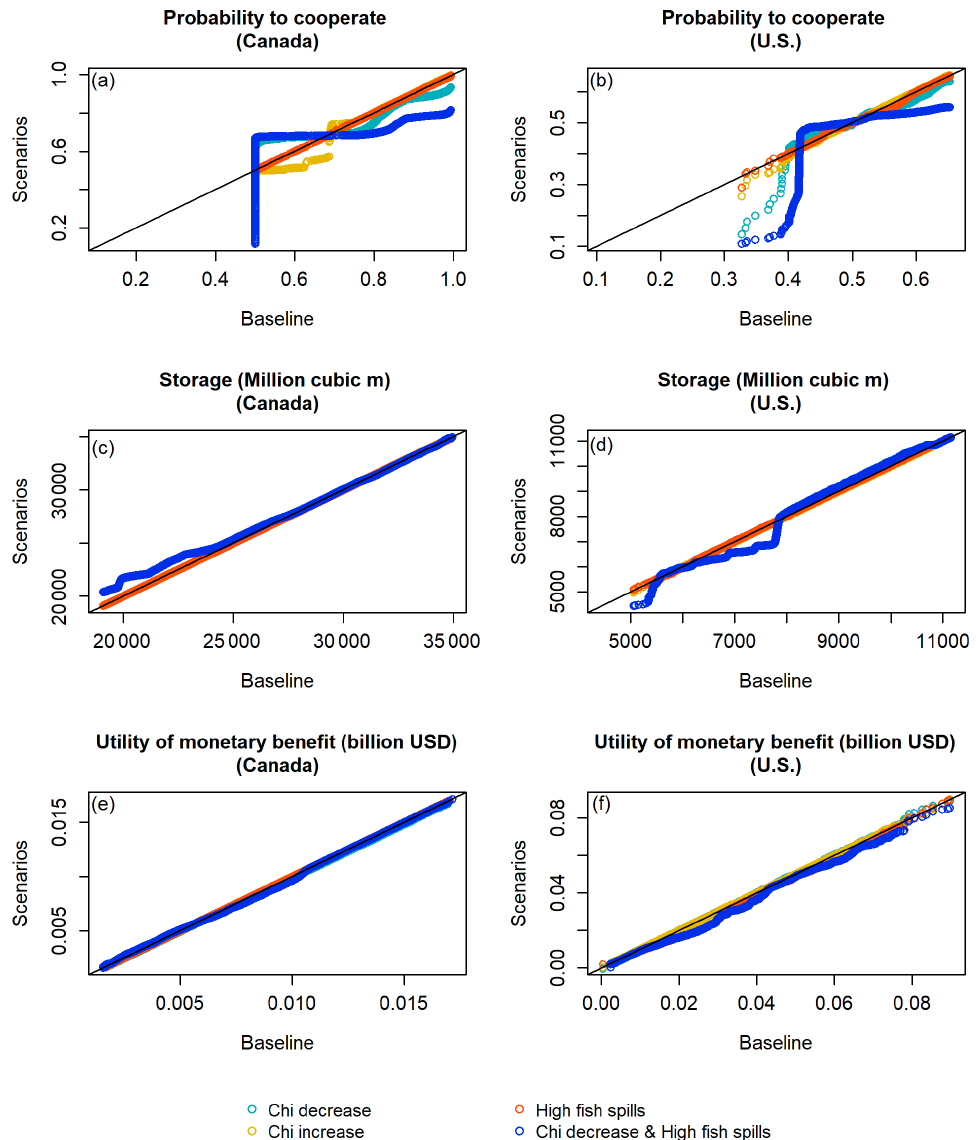
Figure 8. Quantile–quantile plot of the baseline versus other scenarios ( χ decrease, χ increase, high fish spills, and combined χ decrease and high fish spills) comparing probabilities to cooperate, reservoir storage volumes, and utility of monetary